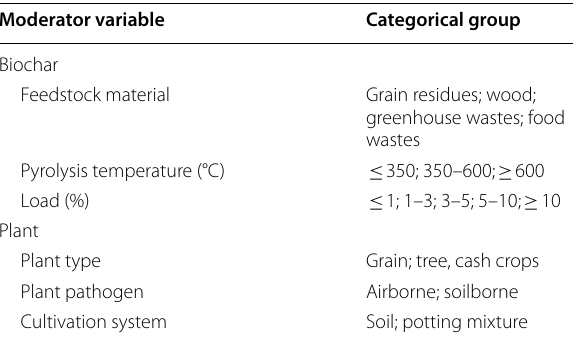
Table 1 Categorical groups of biochar and plants for the